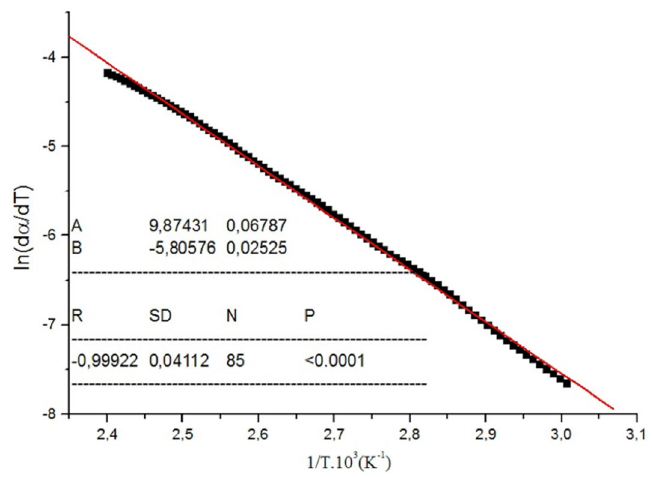
Figure 6. Arrhenius plot for SHEO samples decomposed air atmosphere.